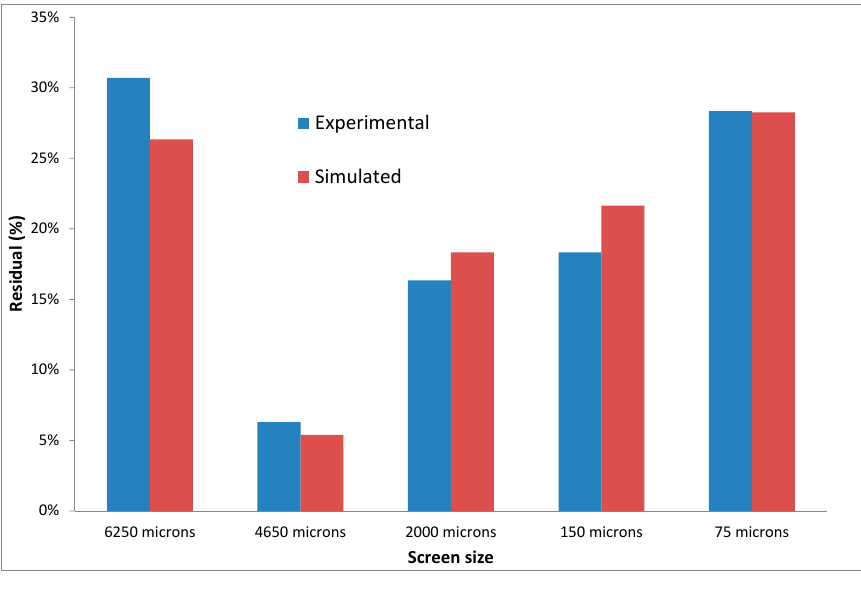
Figure 4. Residual assay of copper distribution.